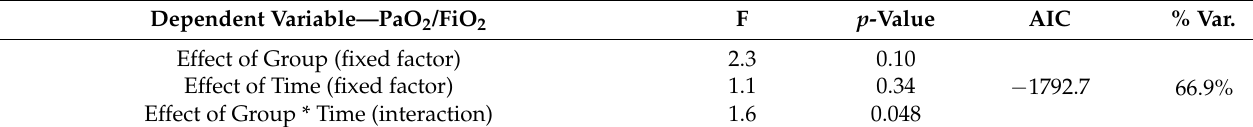
Table 3. Results of mixed-model analyses for PaO 2 /FiO 2 , PaO 2 , and FiO 2